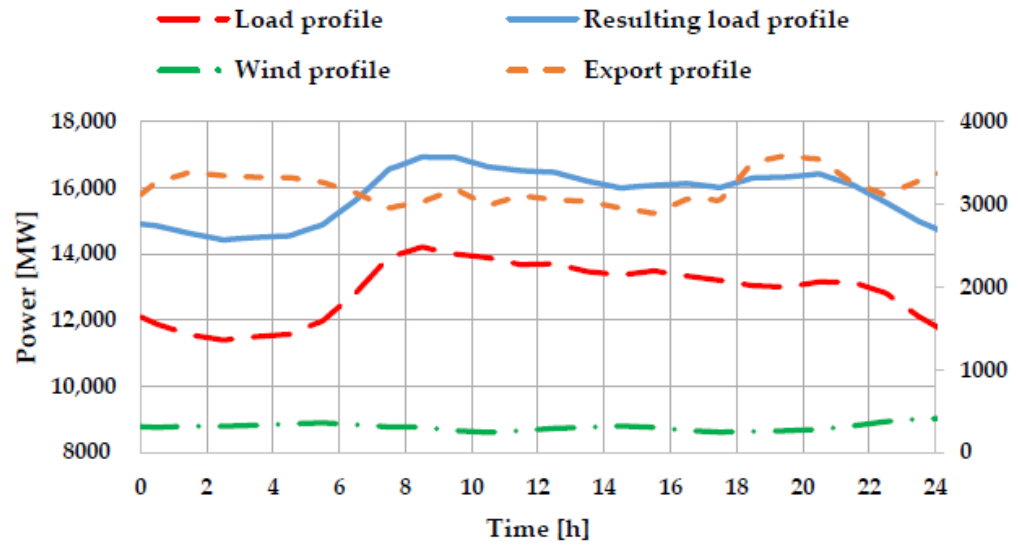
Figure 4. Data for the Norwegian power system on 1 September 2020.